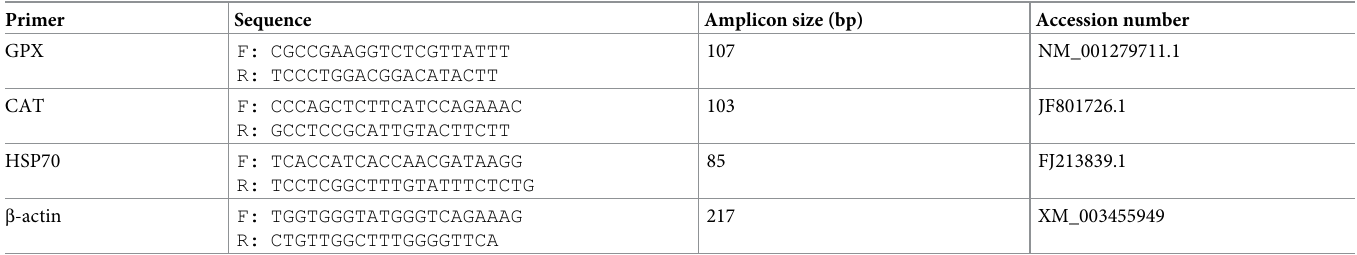
Table 1. Characteristics of the primers used in this